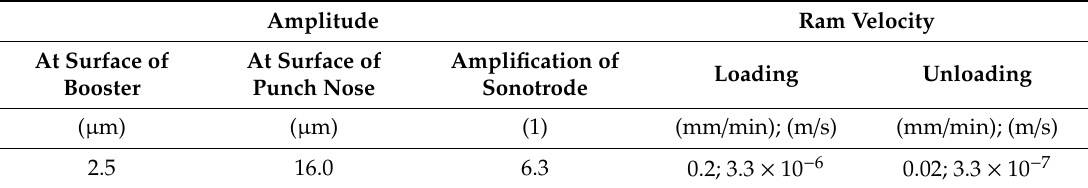
Table 1. System parameters.